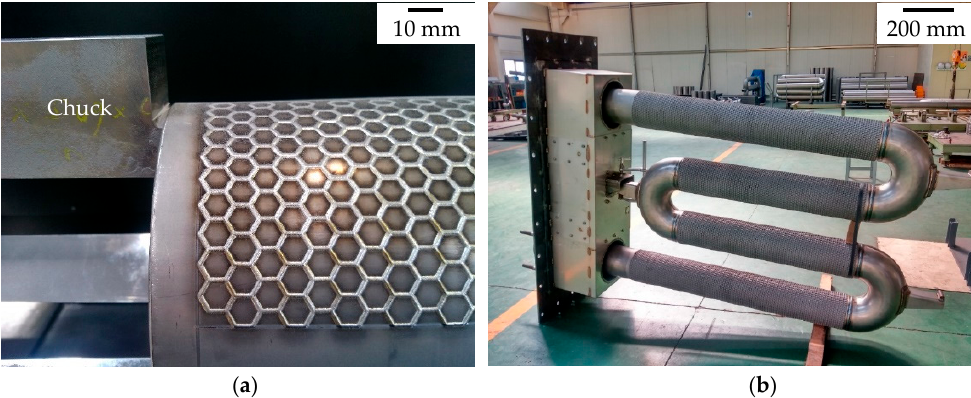
Figure 8. ( a ) The first printed layer of honeycomb pattern of the edge section of a 2000 mm long straight tube. ( b ) The honeycomb patterns were printed on the surface of the straight tube of the prototype RT to be installed in the pilot furnace.